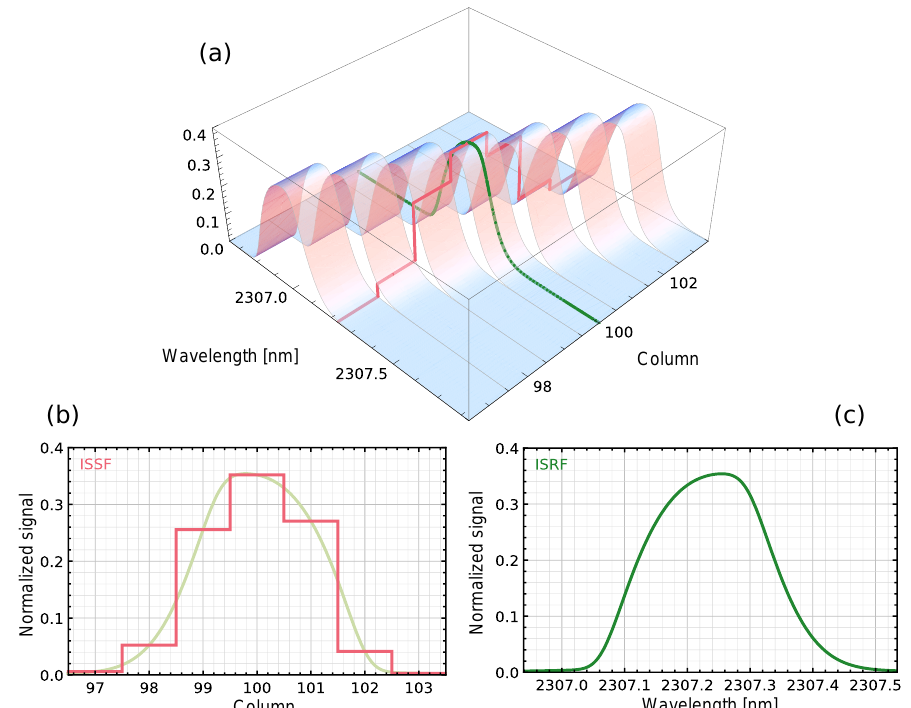
Figure 1. Normalized signal as a function of source wavelength and pixel on an arbitrary row, with two cross sections: the ISSF at 2307.24 nm (red) and the ISRF of the pixel in column 100 (green). In the plot of the ISSF, a mirrored version of the ISRF is shown in light green. The skew of the ISRF has been exaggerated to show the